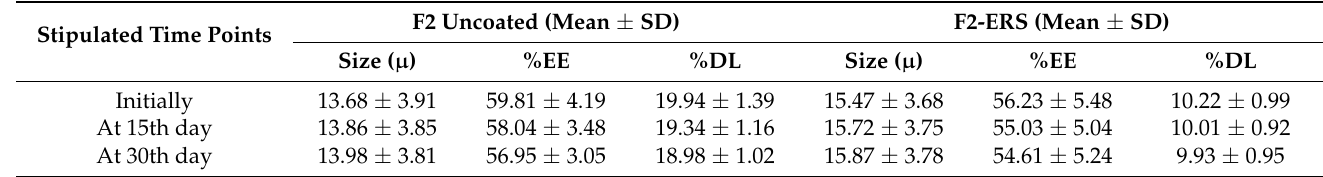
Table 2. Time-dependent evaluation of size, encapsulation efficiency, and drug-loading capacity of F2 and F2-ERS stored at 30 ◦ C for 30